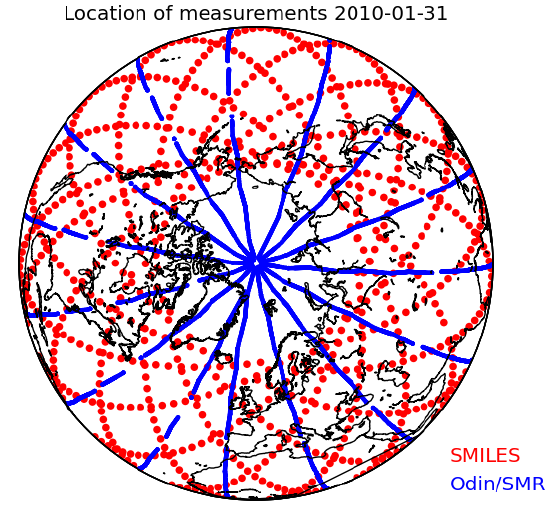
Fig. 1: Minimum ECMWF temperature, T min [K], at a potential temperature of 500K inside the area where the equivalent latitude (EQL) is greater than 70 ◦ , corresponding to the area inside the Arctic polar vortex, as function of days of year (0 refers to 1 January). The black solid line shows